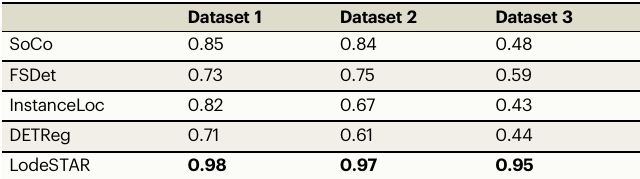
Table 2 | LodeSTAR outperforms other selft-supervised and low-shot